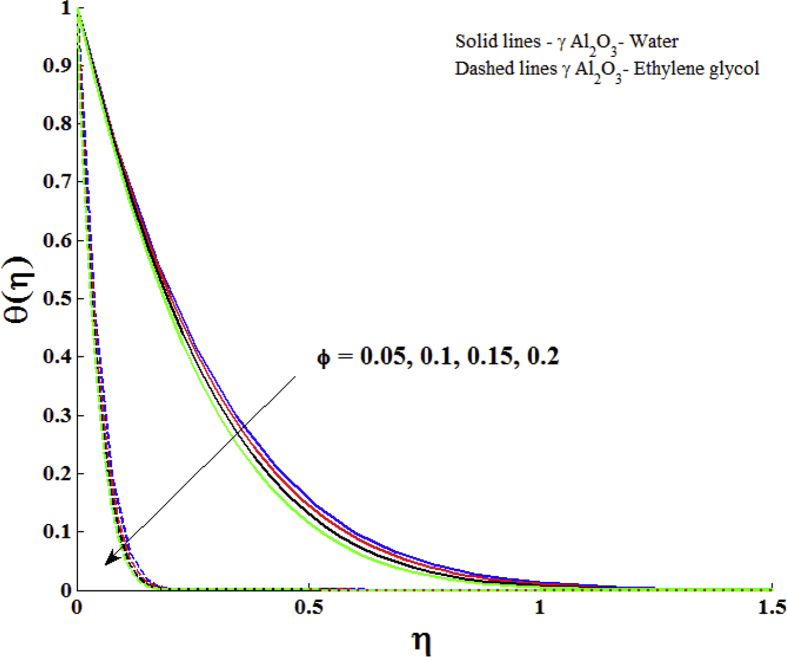
Impact of nanoparticle volume fraction (ϕ) on temperature profile with Z = 2.0, Pr = 6.96 (γ Al2O3- Water) and Pr = 204 (γ Al2O3- Ethylene glycol).